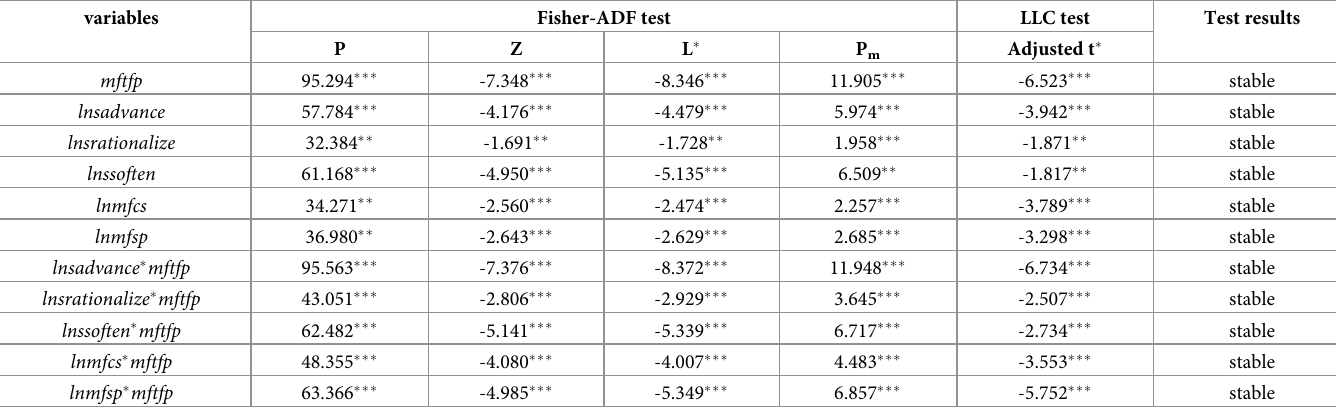
Table 2. Test results of variable